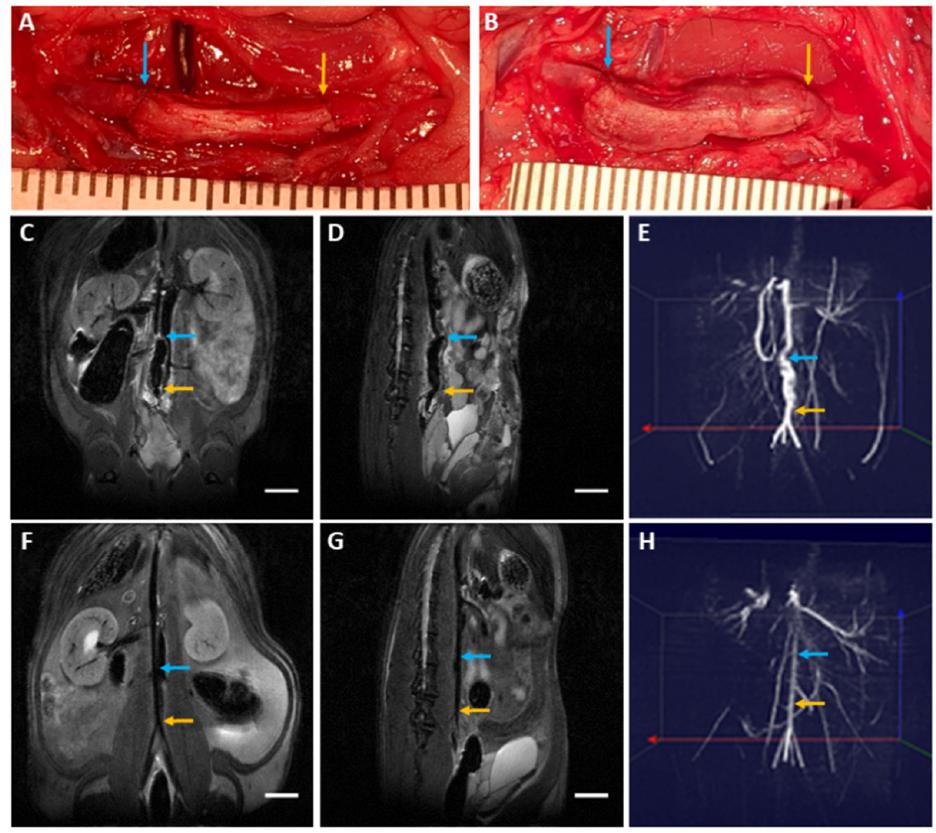
Figure 6. sDHUA implantation and MRI image. ( A ) Gross appearance of the implantation grafts at day-0. ( B ) Gross appearance of the implantation grafts at day-90. ( C ) T2 image of coronal view of implantation graft in rat abdominal cavity. ( D ) T2 image of sagittal view of implantation graft in rat abdominal cavity. ( E ) TOF 3D display of abdominal artery with the implantation graft. ( F ) T2 image of coronal view of naïve rat abdominal cavity. ( G ) T2 image of sagittal view of naïve rat abdominal cavity. ( H ) TOF 3D display of naïve abdominal artery. ( C , D , F , G ) Scale bar = 1 cm; Arrow: anastomosis, blue: near the head, yellow: near the tail.